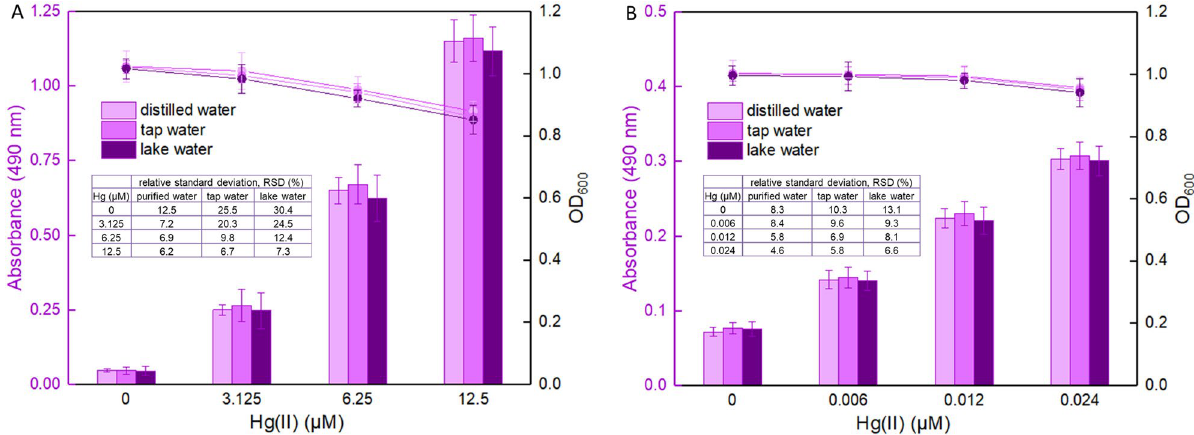
Figure 8. Performance of biosensor cells against environmental water samples spiked with different concentrations of Hg(II). LB-incubated exponential-phase cultures ( A ) or LB-incubated lag-phase cultures ( B ) of whole-cell biosensor TOP10/pPmer-vio were exposed to varying concentrations of Hg(II) in the following water samples: sterile distilled water, unsterilized tap water and unsterilized lake water. After culturing at 37 °C for 12 h, the bacterial density (OD 600 ) was first determined (point line diagram, right-Y scale), and then the butanol-extracted violacein was determined at 490 nm (bar chart, left-Y scale). Relative standard deviation (RSD) is shown in the table embodied in the